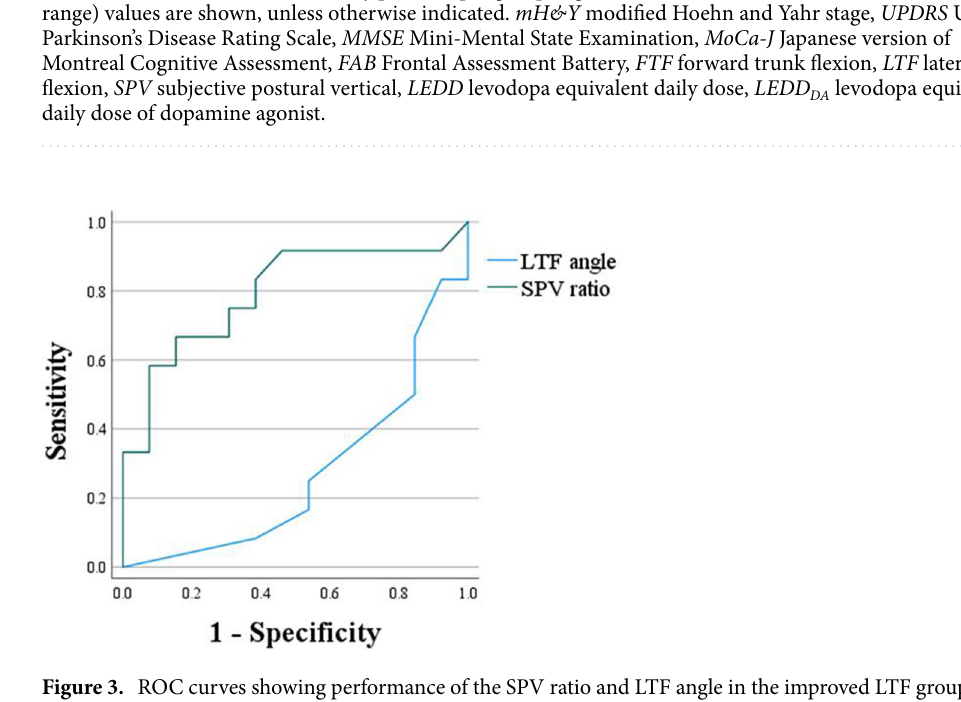
Figure 3. ROC curves showing performance of the SPV ratio and LTF angle in the improved LTF